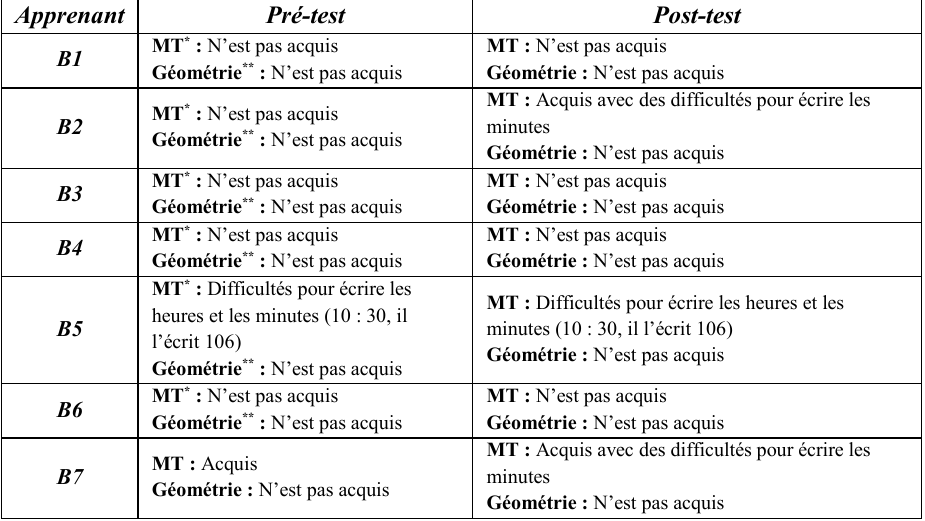
Tableau 5 : Les résultats du pré et du post-test de l’échantillon témoin ( MT : Distinguer entre les minutes et les heures ; Géométrie : Distinguer entre les distances longues et